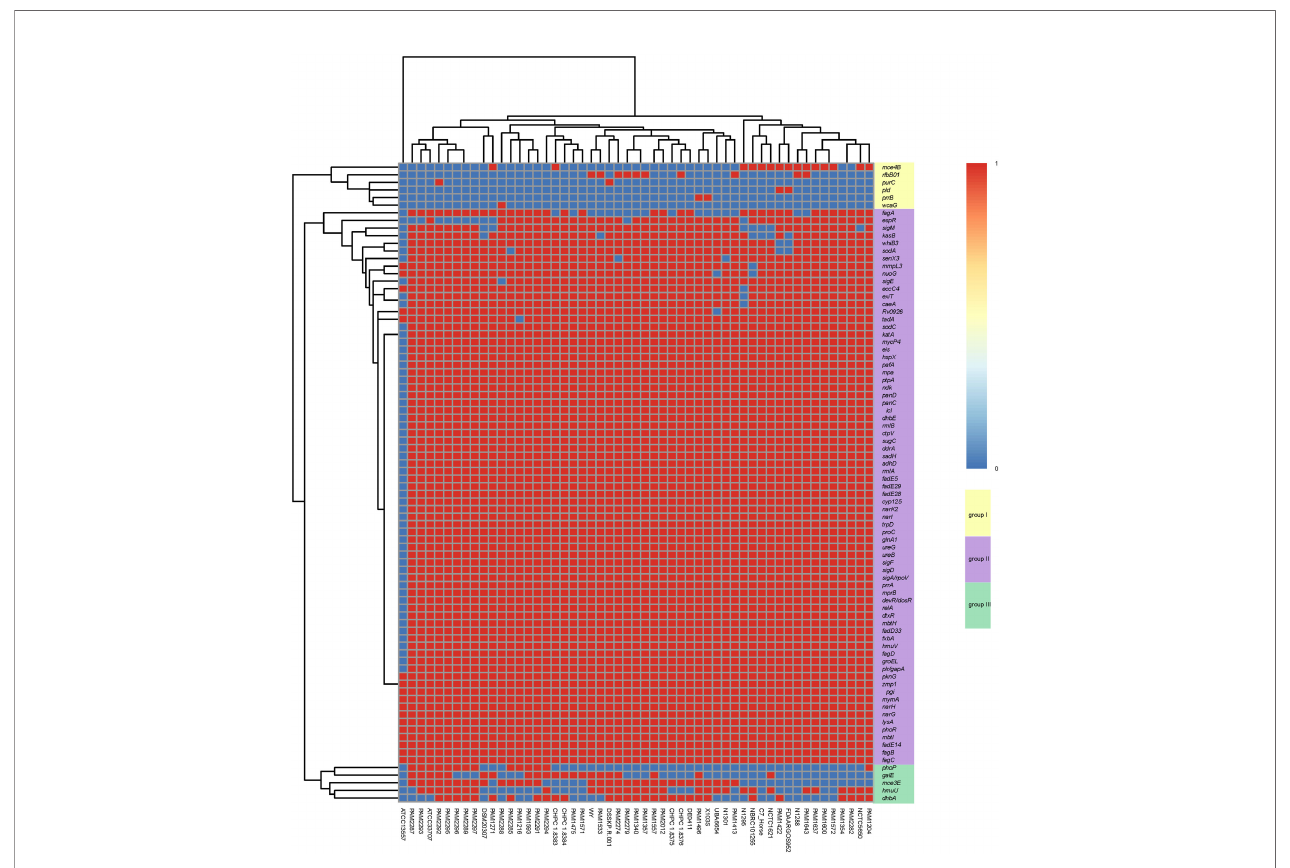
FIGURE 5 | Heat map of virulence gene distribution in 53 R. equi strains. The predicted virulence genes were shown on the right. The strain names were shown at the bottom. The red color represented the presence of genes, while the blue color represented the absence.